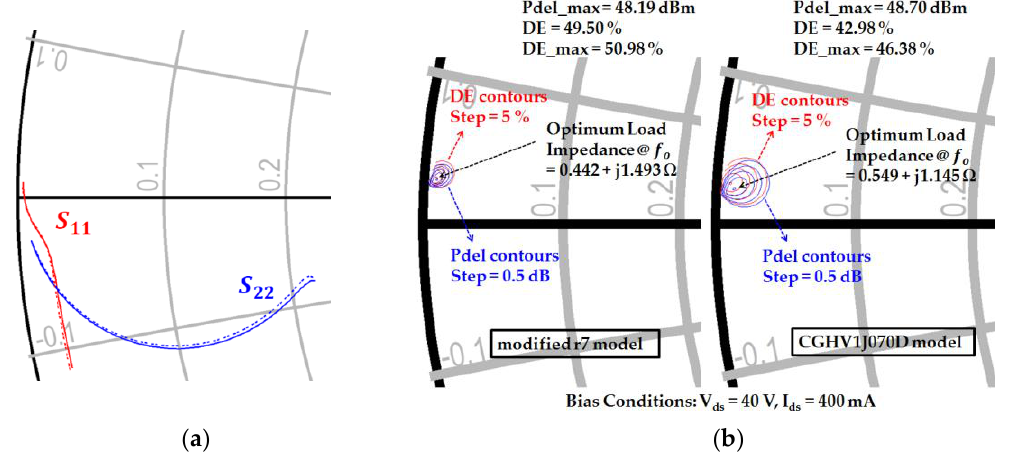
Figure 2. Comparison of S-parameter and load-pull simulation results of the conventional large-signal CGHV1J070D model and our modified r7 model: ( a ) S-parameter simulation; ( b ) load-pull simulation ( left : modified r7 model, right : conventional CGHV1J070D